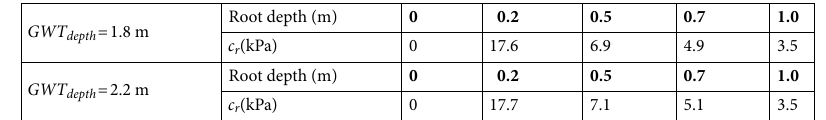
GWT depth = 1.8 m